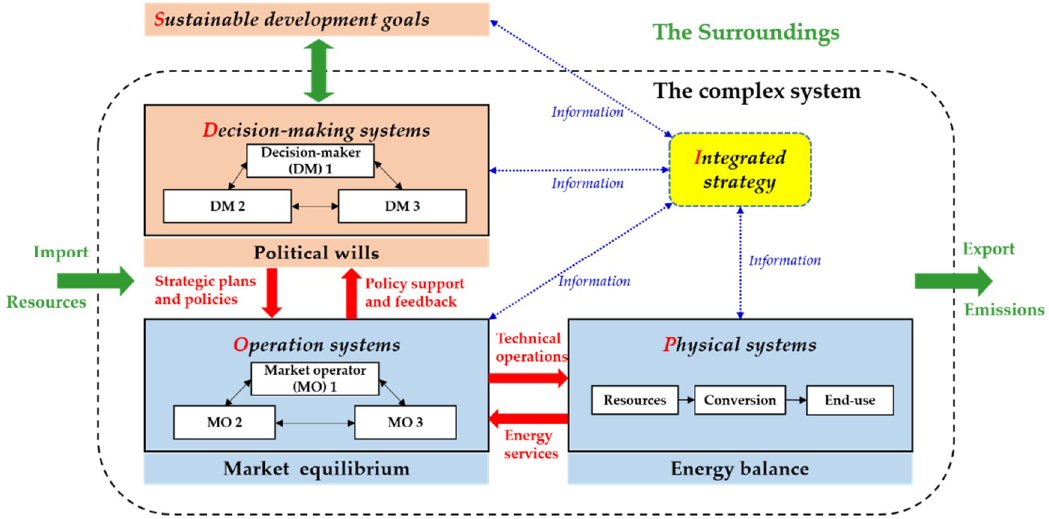
Figure 1. An illustration of the Integrated strategy of Sustainable development objectives, Decision- making systems, Operation systems, and Physical systems (I-SDOP) concept.